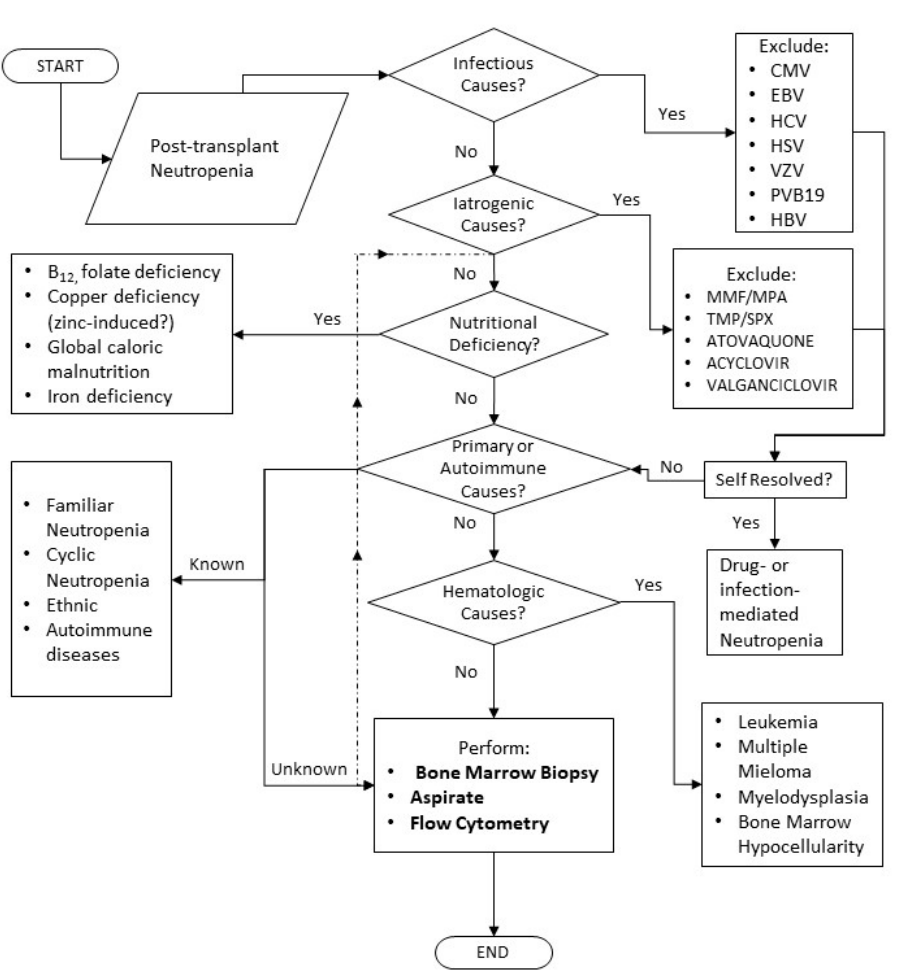
Figure 2. The diagnostic algorithm conceived and applied to the clinical case described.